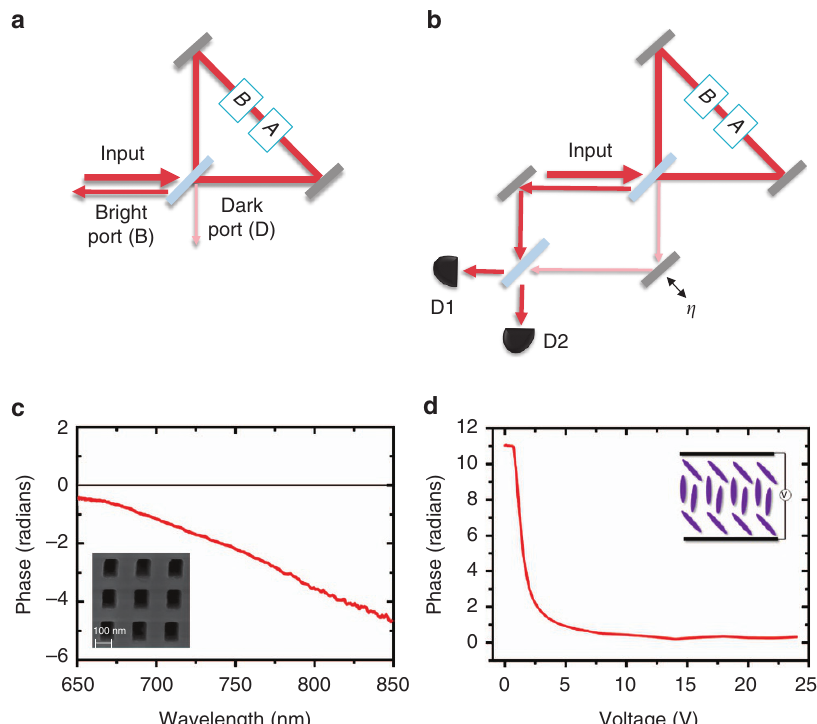
Figure 1 | Experimental schematic and phase characterization. ( a ) If two different phases A and B are placed inside a Sagnac interferometer and, if the phases commute, all the incoming light should exit through the ‘bright port’, while there should be no light in the ‘dark port’. If A and B do not commute the dark port will not be dark. ( b ) Adding a Mach–Zehnder interferometer to interfere the bright and dark ports allows for a more precise measurement of the leakage into the dark port. ( c ) Wavelength dependence of the phase shift of our negative index metamaterial. For the wavelength of our single photons, 790nm, the measured phase is about (cid:3) p , which corresponds to a refractive index of the multilayer fishnet of (cid:3) 0.4. Inset: SEM image of the negative index metamaterial. ( d ) Phase response of the nematic liquid crystal. The measured relative phase (modulo 2 p ) between the LC and the air for transmitted light is about þ p . Inset: representation of a liquid